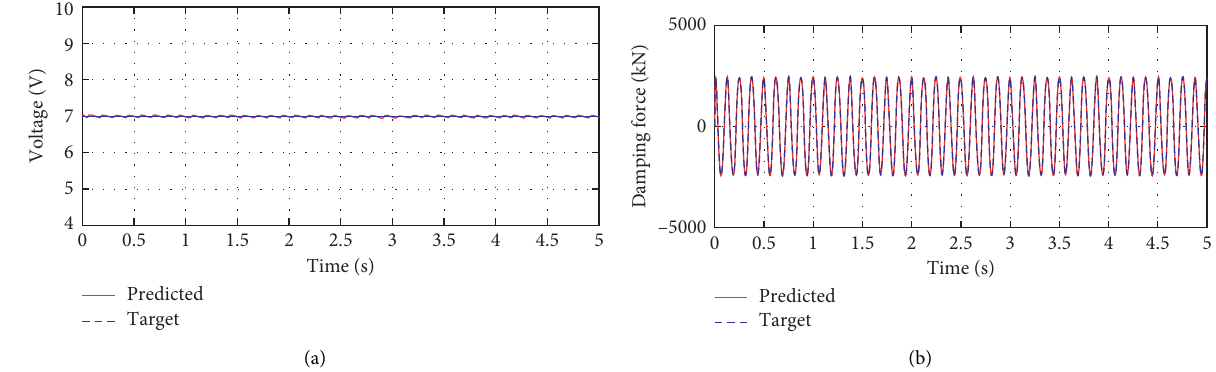
Figure 7: Predicted and target voltages (damping forces) for validation dataset